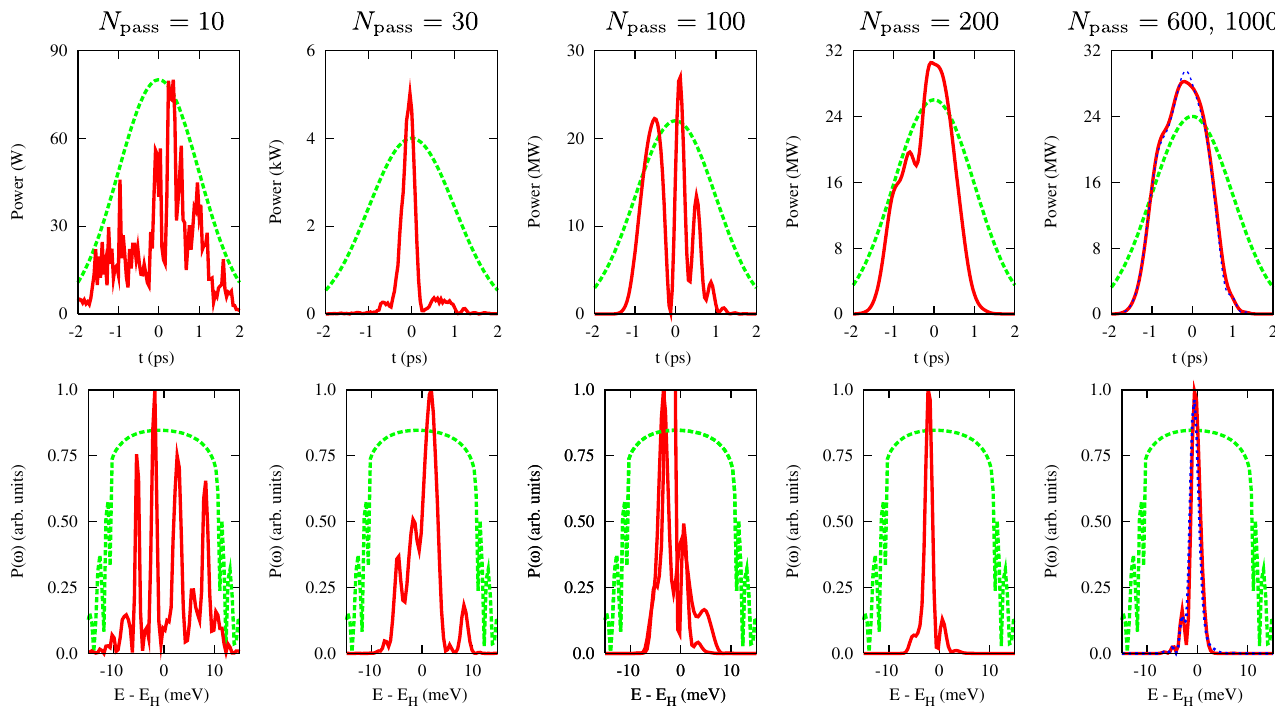
FIG. 7. Snapshots of the trapped cavity radiation for a typical simulation of the x-ray FEL oscillator at 1 A˚ (parameters are listed in Table I). The top row shows the transverse-averaged power in solid (red) lines, with the 1 ps electron beam current profile displayed by the dotted (green) line for comparison. The bottom row plots the normalized radiation spectrum with the solid (red) line, and includes the total reflectivity of the Bragg crystals (including the artificial decrease to 85% total reflectivity) as the dotted (green) line. The time and spectral properties fluctuate significantly until saturation around 200 passes, after which a slow evolution occurs until a near- equilibrium state is reached around pass number 500. The final panel includes both power and spectral profiles at both 600 and 1000 passes, which are nearly identical. After pass 1000, the temporal and spectral properties of the transmitted radiation are nearly identical to that in the cavity, with the only difference being a decrease in the energy/power of the output to (cid:1) 4% – 5% of the cavity